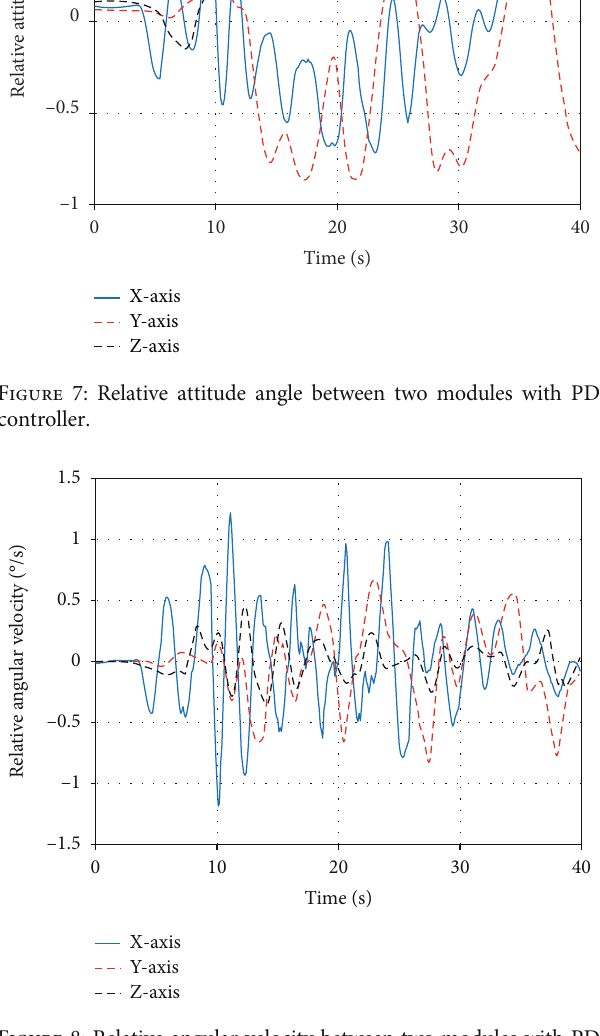
Figure 8: Relative angular velocity between two modules with PD